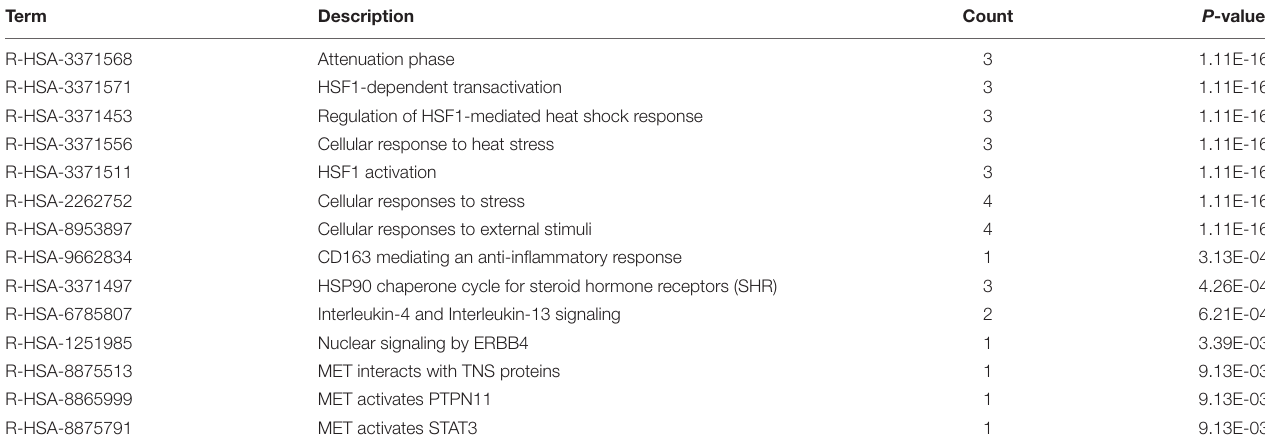
TABLE 4 | Pathway enrichment analysis of Module 2 genes